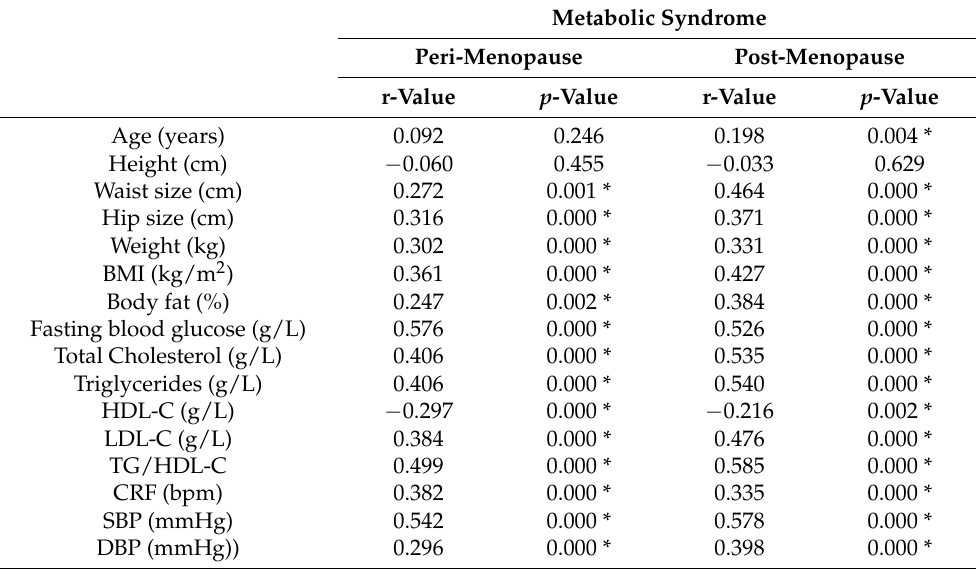
Table 4. Correlation between biological characteristics and metabolic syndrome in peri- and post- menopausal